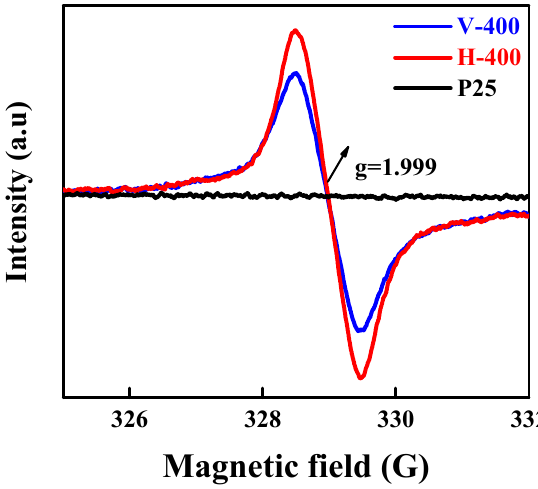
Figure 3. XPS spectra of Ti 2p peaks ( a ) and O 1s peaks ( b ) for P25, H-400 and V-400.